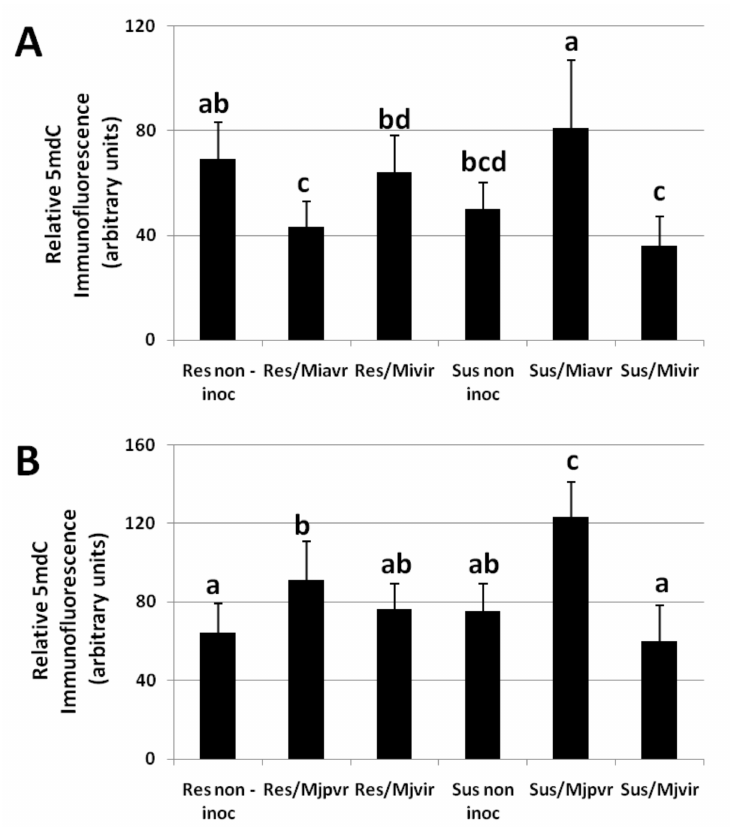
Figure 4. Arbitrary units of methylation on total DNA in roots of susceptible and resistant tomato plants un-inoculated or inoculated with 2 couples of field populations / virulent isolates of RKNs. Data were taken at 7 DAI. DNA was extracted from resistant (Res non-inoc, Rossol) and susceptible (Sus non-inoc, Roma VF) un-inoculated plants. In A , DNA was also extracted from roots of Rossol and Roma VF plants inoculated with the avirulent Meloidogyne incognita field population Mi-Vfield and the selected virulent isolate SM2V : Rossol / Mi-Vfield (Res-Miavr); Rossol / SM2V (Res-Mivir); Roma VF / Mi-Vfield (Sus-Miavr); Roma VF / SM2V (Sus-Mivir). In B , DNA was also extracted from roots of Rossol and Roma VF plants inoculated with the partially virulent Meloidogyne javanica field population Mj-Tunc2field and the selected virulent isolate SM11C2 : Rossol / Mj-TunC2field (Res-Mjpvr); Rossol / SM11C2 (Res-Mjvir); Roma VF / Mj-TunC2field (Sus-Mjpvr); Roma VF / SM11C2 (Sus-Mjvir). Values are expressed as arbitrary units of relative 5mdC immunofluorescence and as means ( n = 6) ± SD. Means were separated by a Duncan’s Test (Significance Level: